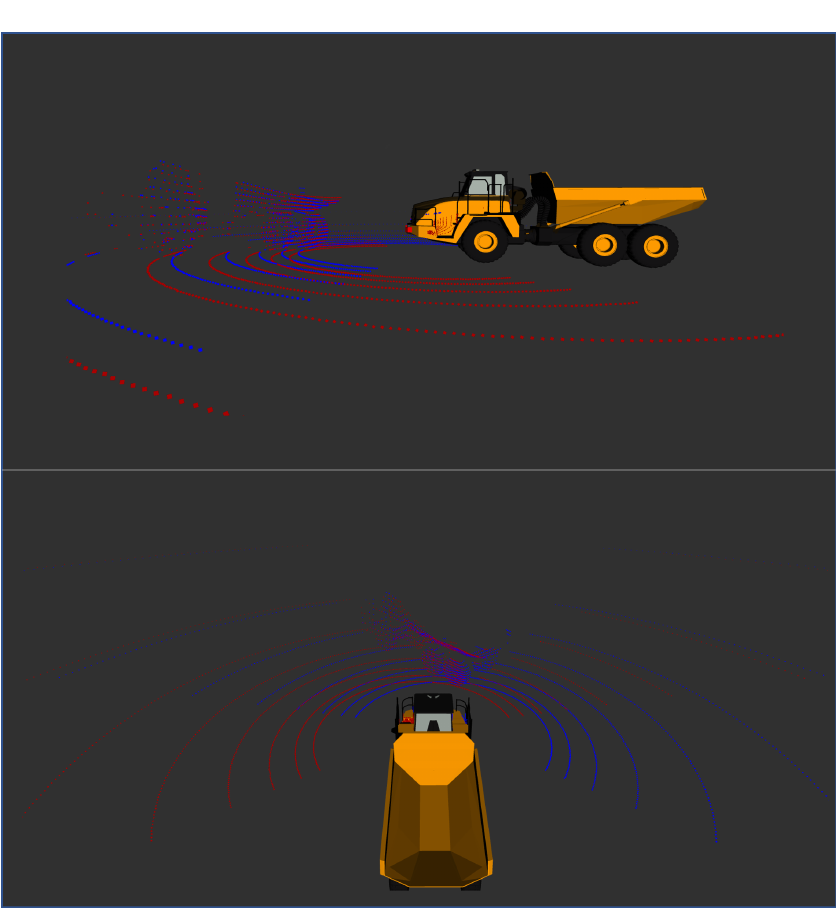
Figure 6. Sensor view in rviz. The output of two LiDARs (red and blue) and the truck model is visualized.